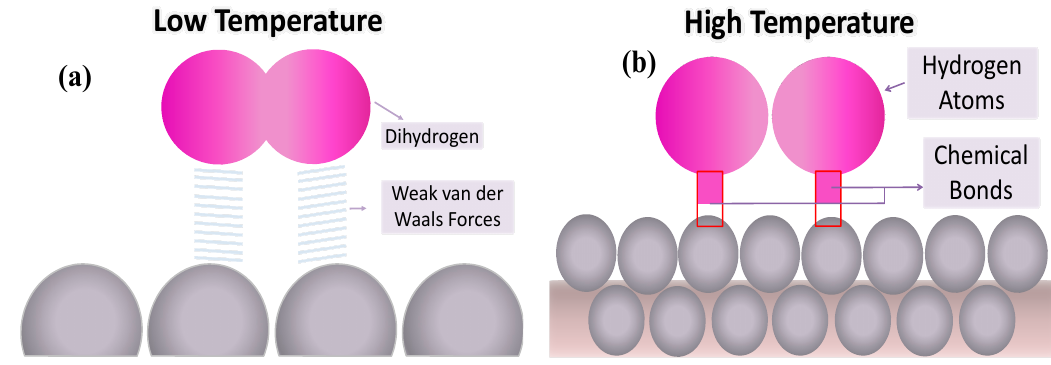
Figure 1. Scheme of ( a ) physisorption and ( b ) chemisorption. Table 2. Di ff erences between physisorption and